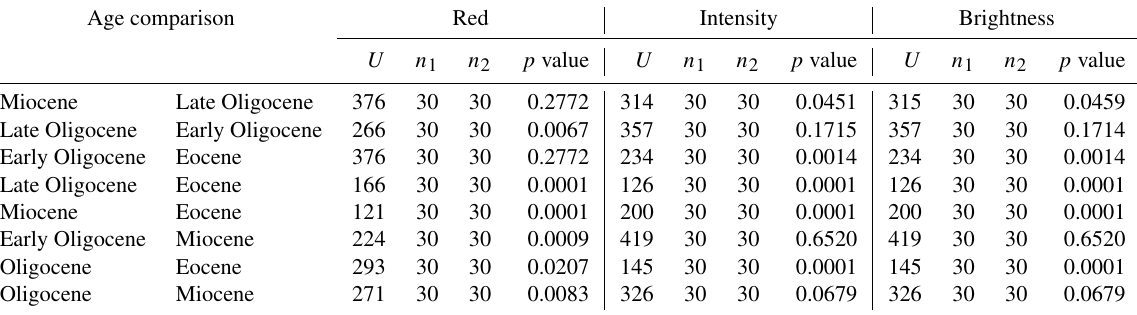
Table 2. Mann–Whitney U test values correlating the red fluorescence, intensity, and brightness throughout the Eocene to the Miocene. Larger U statistic values indicate fluorescence similarity and smaller U statistic values show greater separation of fluorescence between time